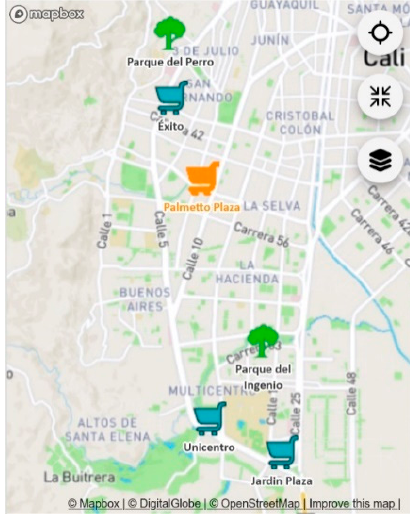
Figure 6. Map-reading task T2 (select a point feature) with the Simple map.